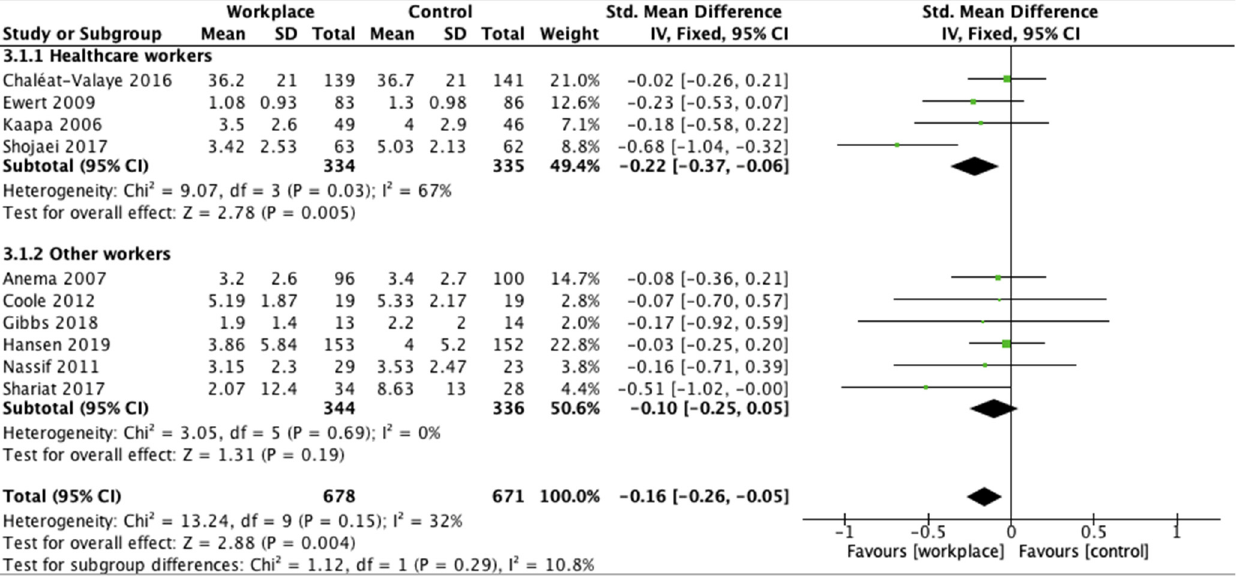
Figure 6. Low back pain recurrence.